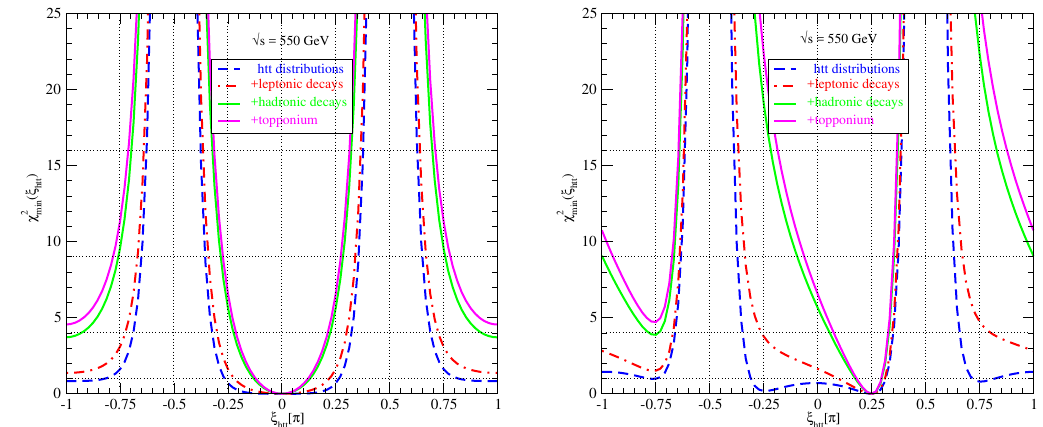
= 0 as the observed data (left panel) and htt